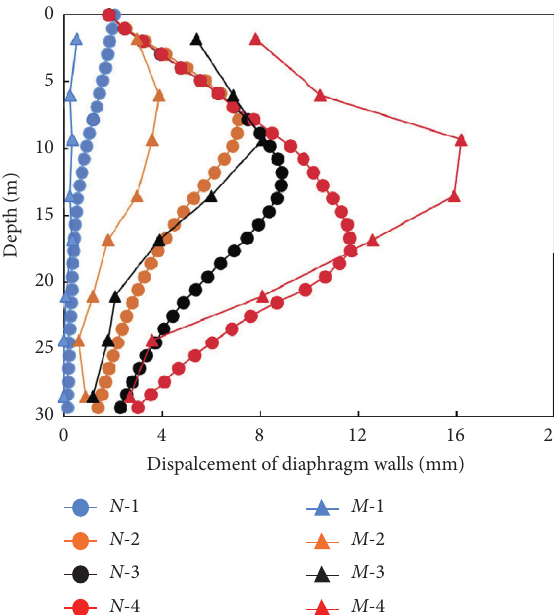
Figure 9: Diaphragm wall displacement of 0.4 H.